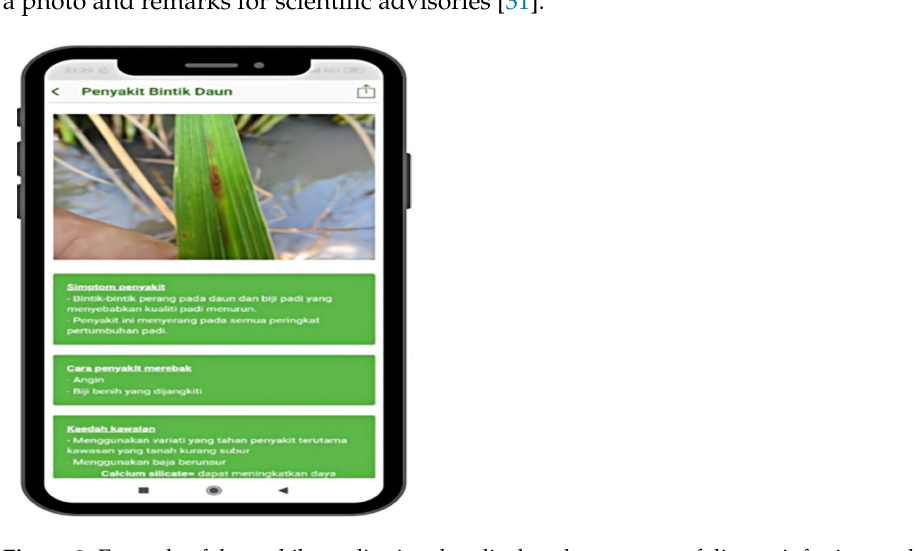
Figure 2. Example of the mobile application that displayed symptoms of disease infection on the